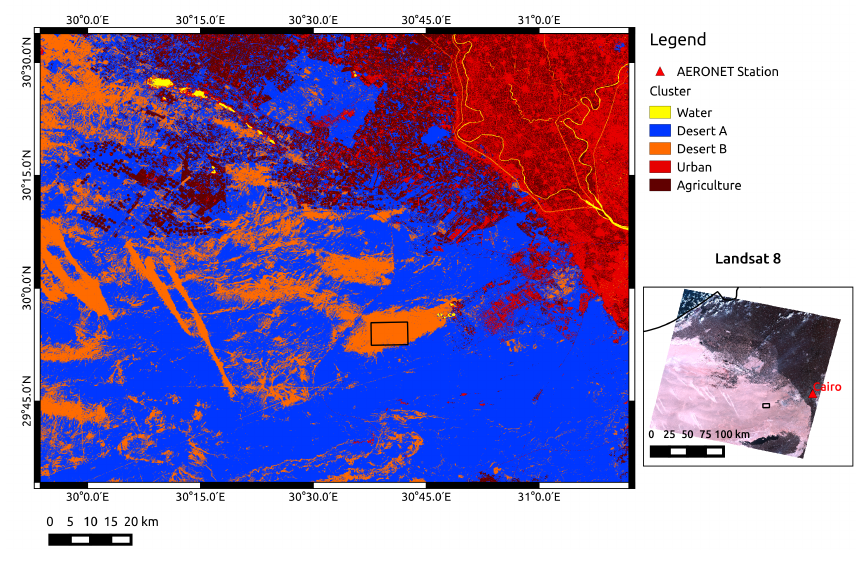
Figure 4. Unsupervised classification of the study area with main land cover clusters.